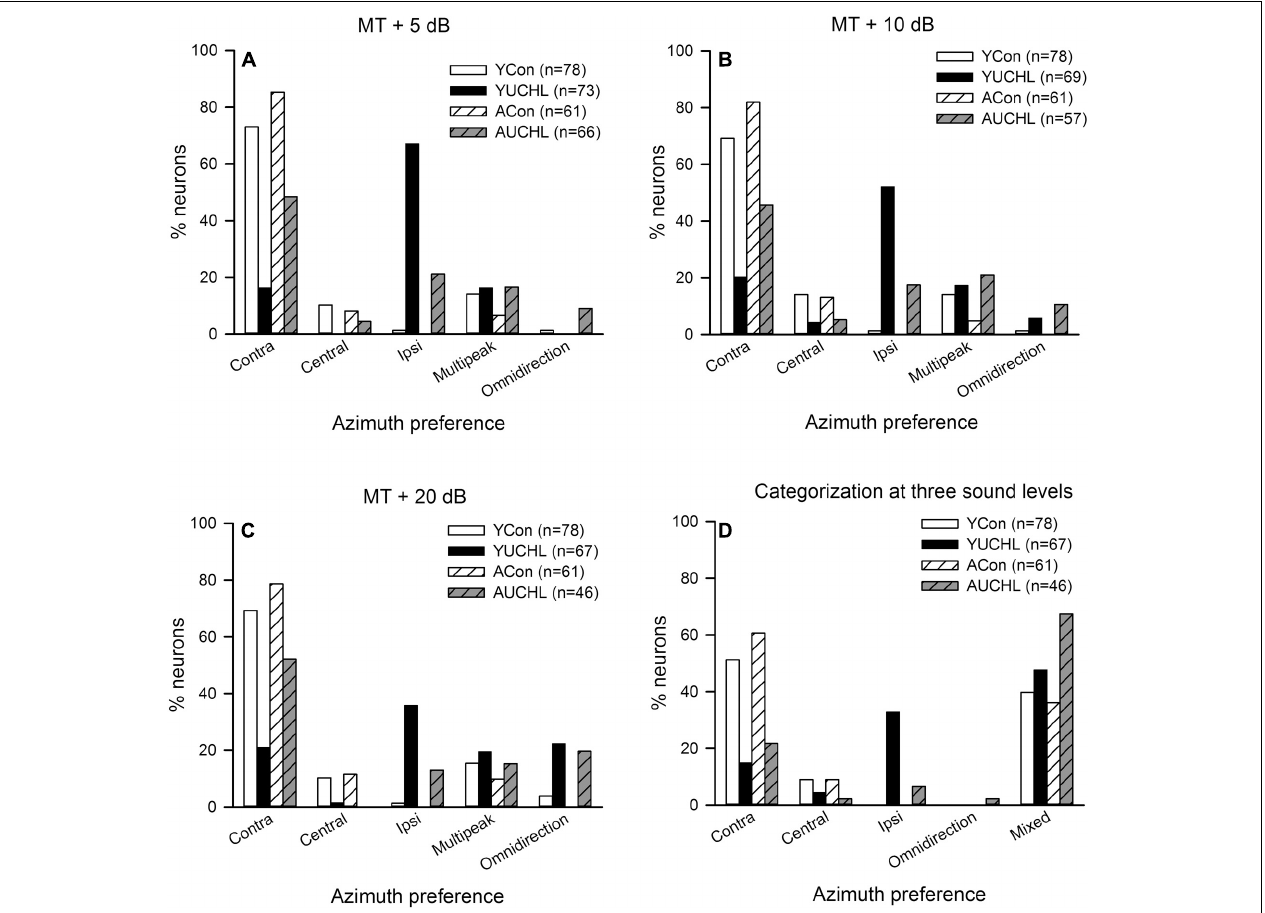
FIGURE 6 | Comparison of the azimuth preference of AI neurons in the four groups of rats. Contra, contra-field preference; Central, central-field preference; Ipsi, ipsi-field preference. Panels (A–C) show the percentage of AI neurons with different azimuth preferences determined at each of the three sound levels, i.e., MT + 5 dB, MT + 10 dB, and MT + 20 dB, respectively. Panel (D) shows the comparison of the overall azimuth preferences of AI neurons categorized from the azimuth functions determined at all the three sound levels in the four groups. The azimuth preference of an AI neuron was categorized as “mixed” when the azimuth preferences determined at the three sound levels are inconsistent. The ‘n’ in the legend of each panel show the number of neurons included in the data